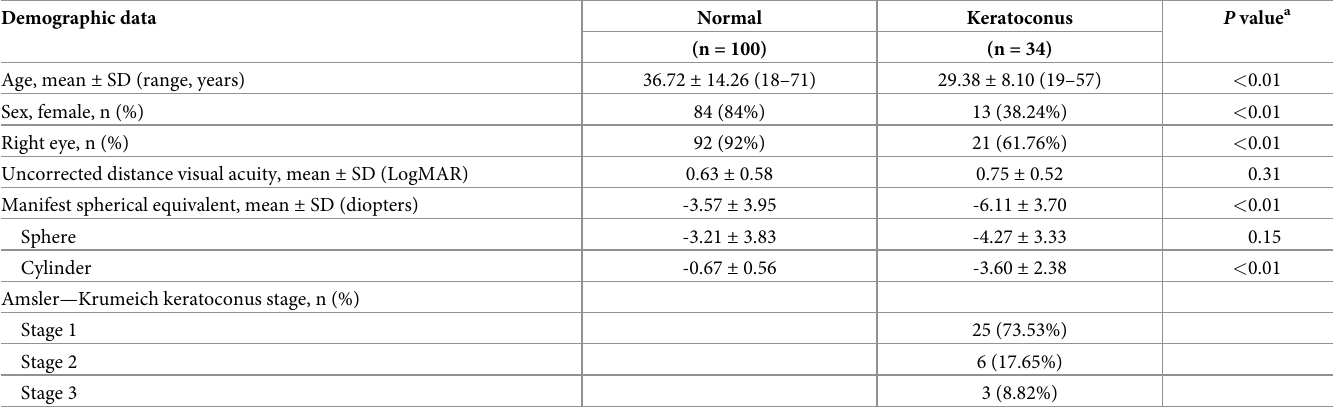
Table 1. Demographic